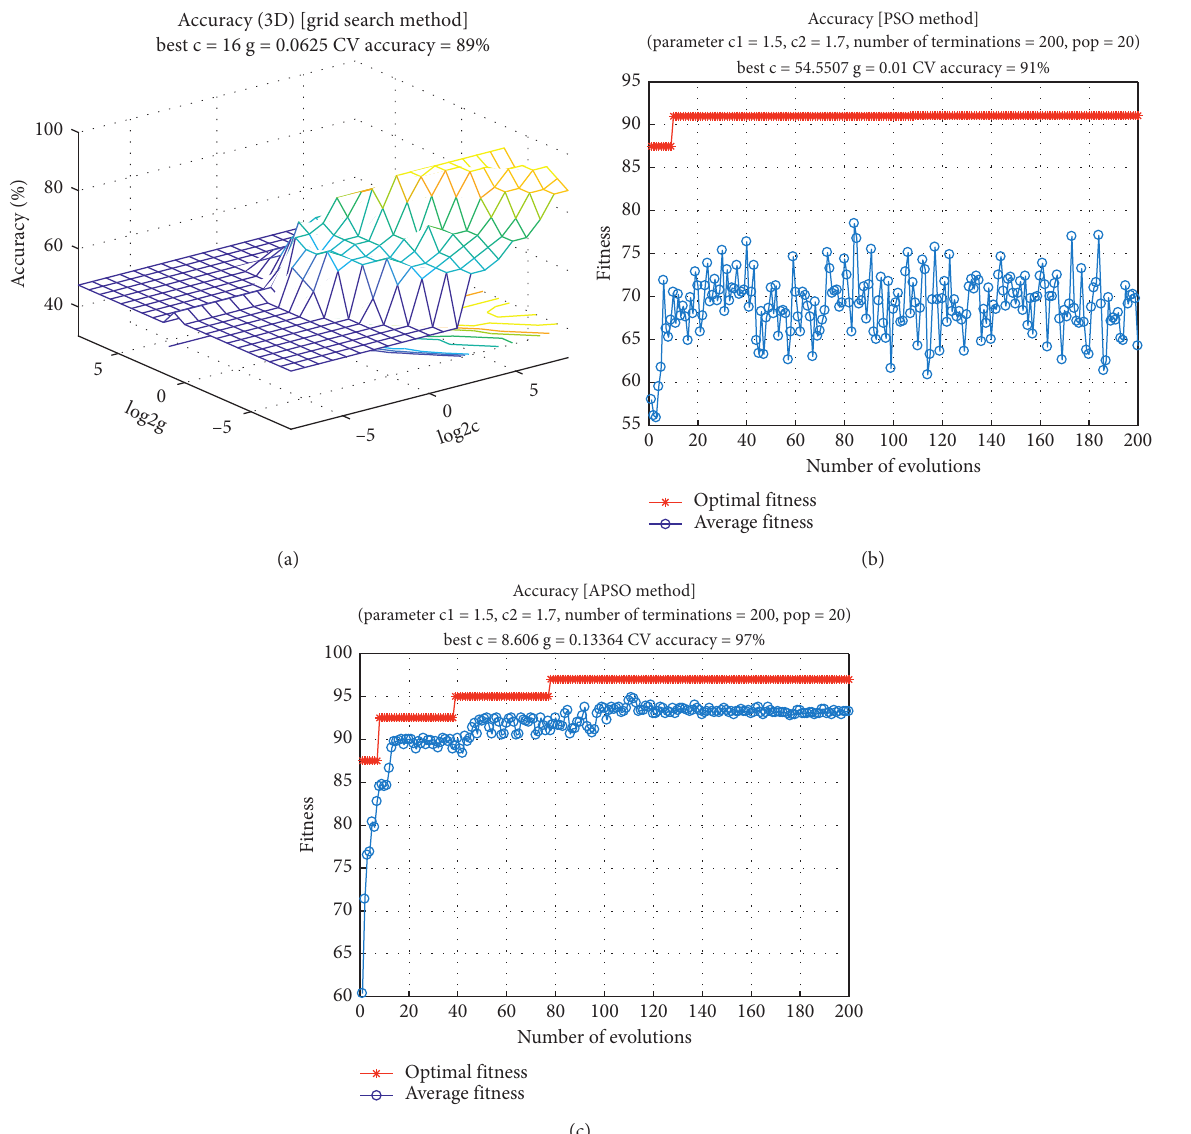
Figure 3: Parameter optimization effects of the three algorithm models. (a) Parameter calculation results by grid search method. (b) Parameter calculation results by PSO method. (c) Parameter calculation results by APSO